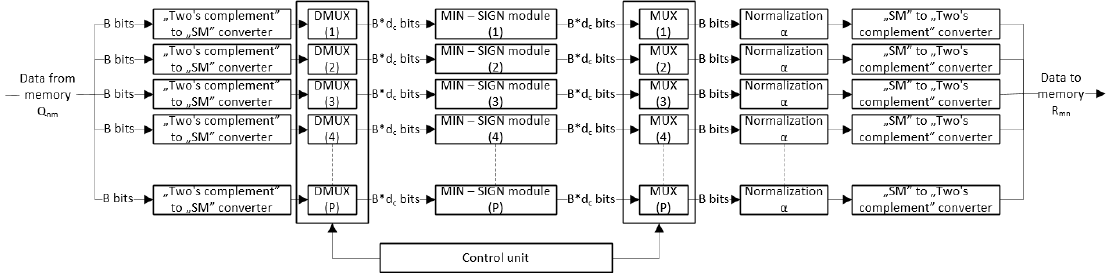
Figure 7. Block diagram of the unit calculating the control nodes messages R mn